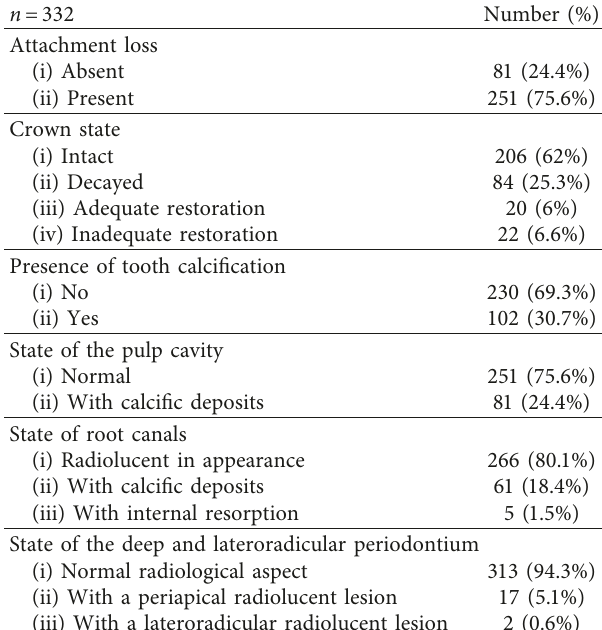
Figure 1: Flowchart of the study. Table 2: Dental and periodontal characteristics of the examined teeth ( n � 332).